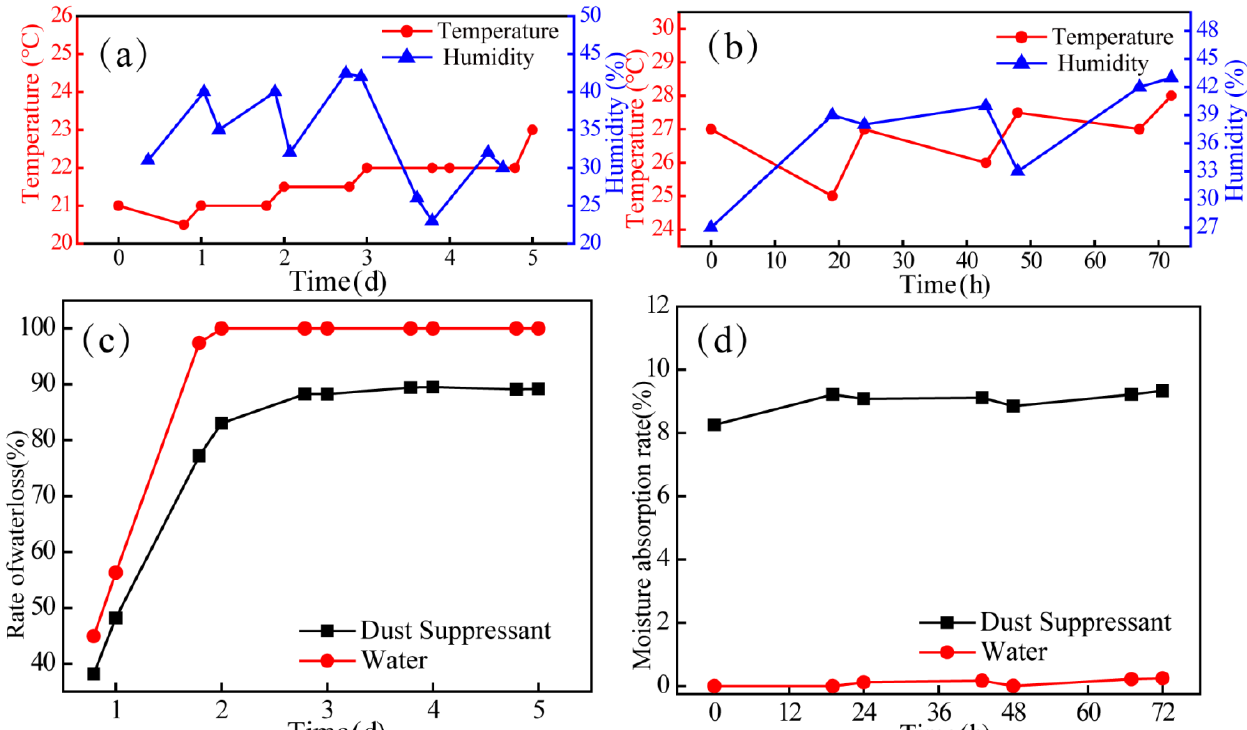
Figure 7. ( a ) Changes in ambient temperature and moisture during moisture retention test; ( b ) changes in ambient temperature and moisture during hygroscopicity test; ( c ) variation curves of water loss rate for samples under natural conditions; ( d ) variation curves of moisture content rate for samples under natural conditions.